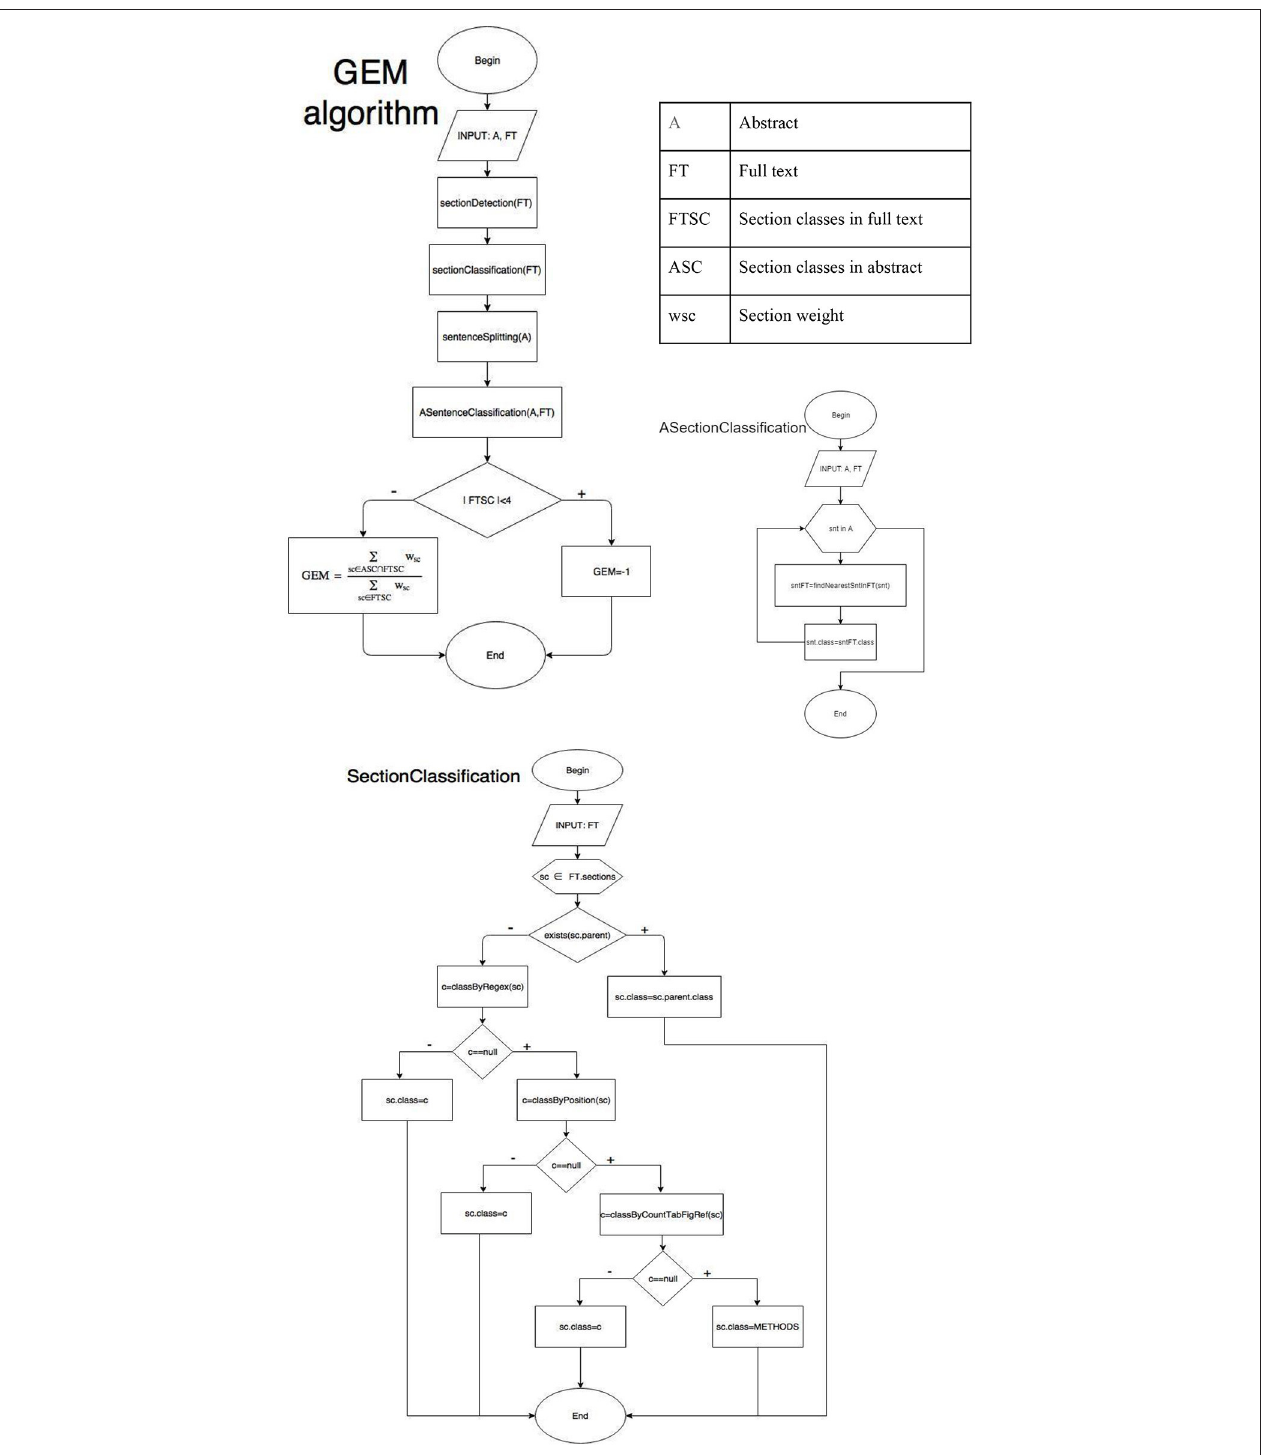
FIGURE 3 | GEM calculation